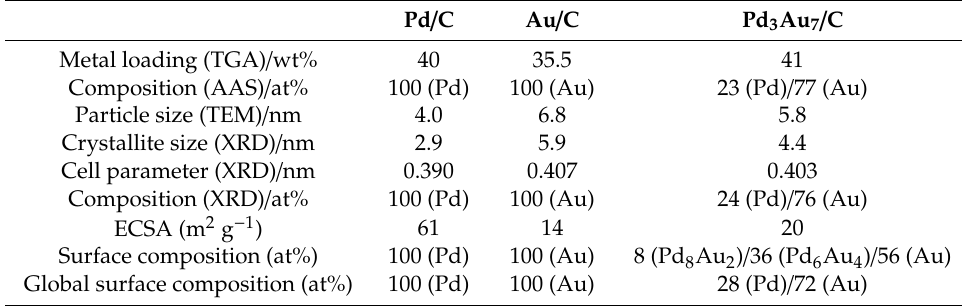
Table 1. Characterization data of Pd / C, Au / C and Pd 3 Au 7 / C by TGA, AAS, TEM, XRD and